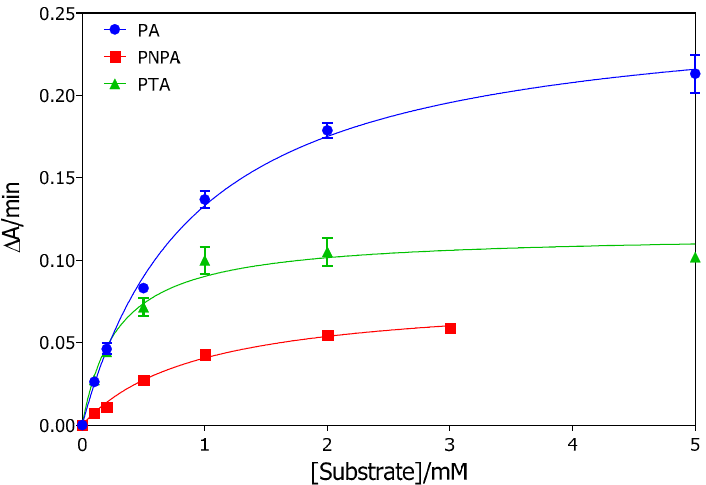
Figure 1. Structures of selected carbamates.